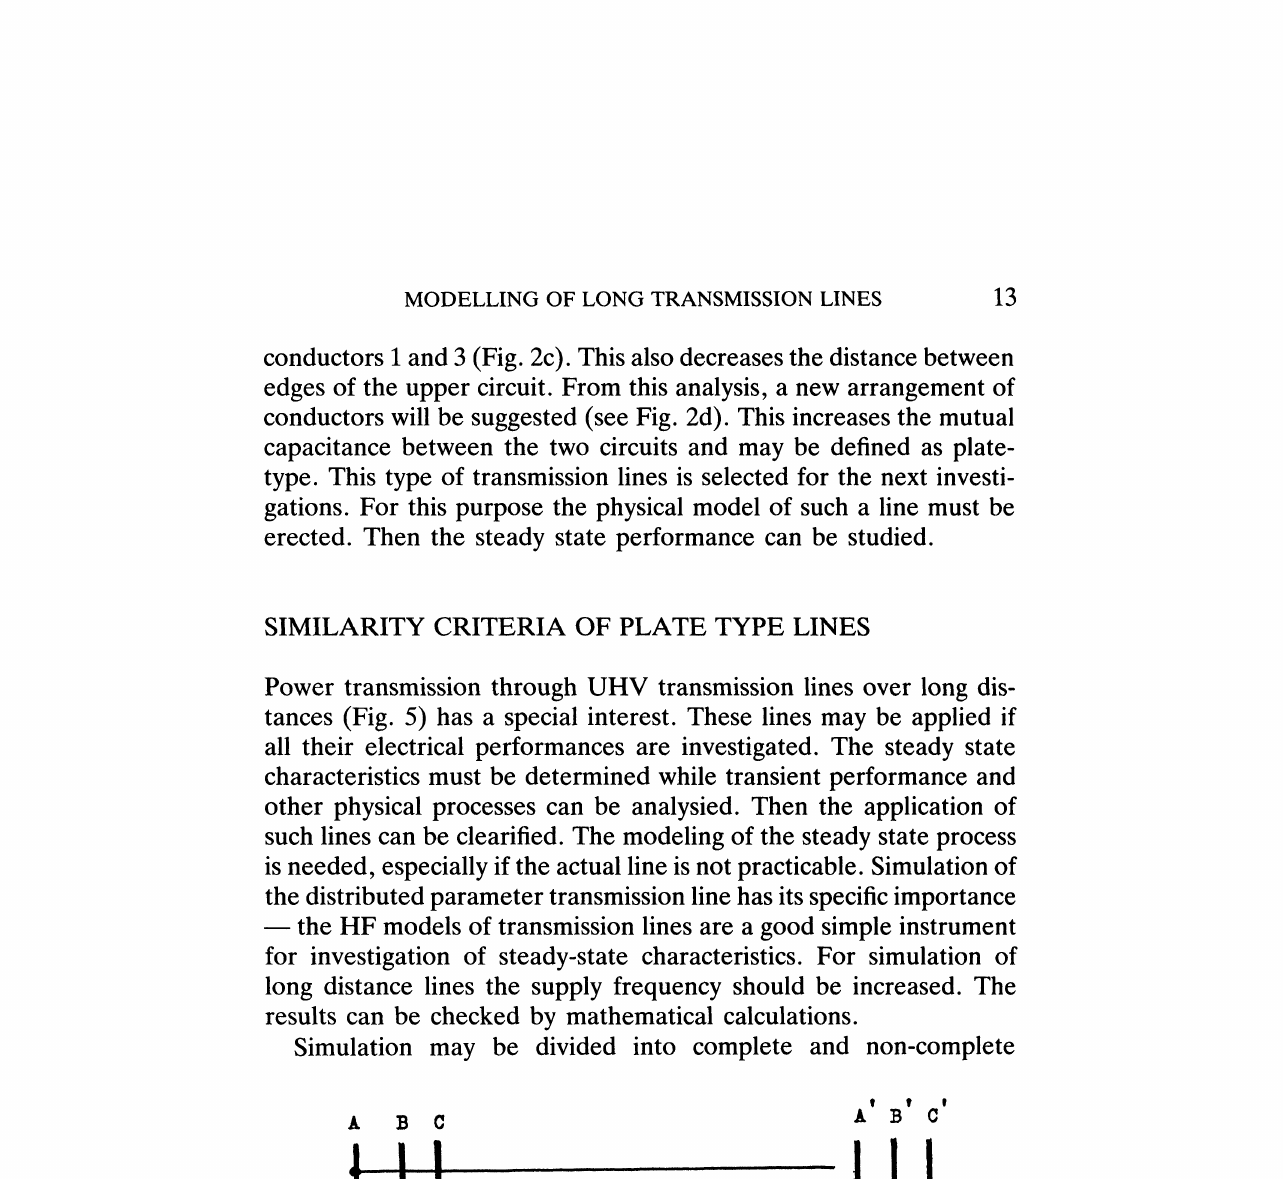
FIGURE 5 The three wire diagram for the proposed transmission line with plate